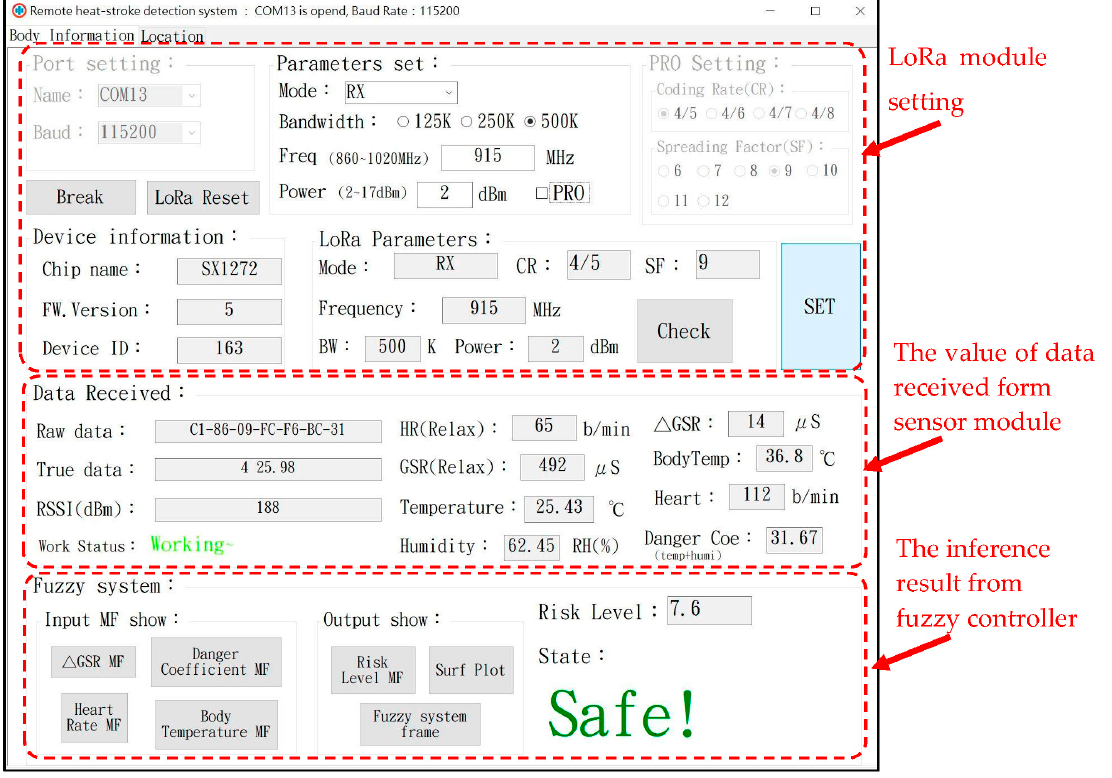
Figure 2. User interface of the risk evaluation module.